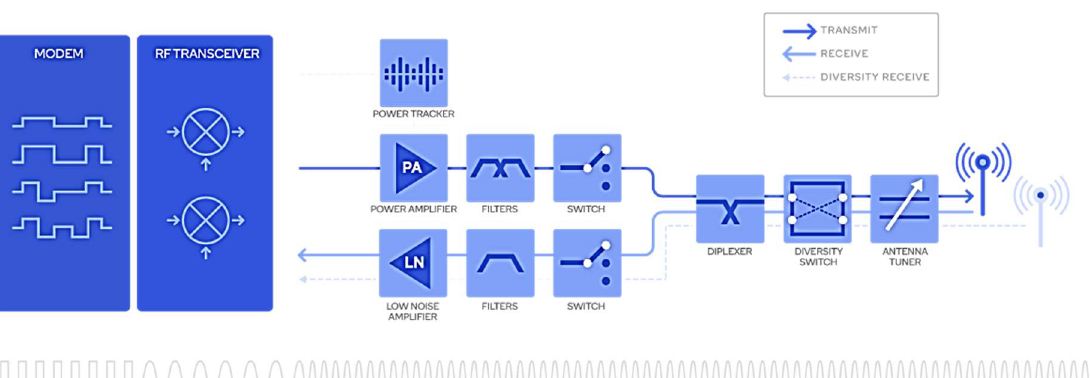
Figure 1. Qualcomm Radio Frequency Front-End (RFFE) solution [2].